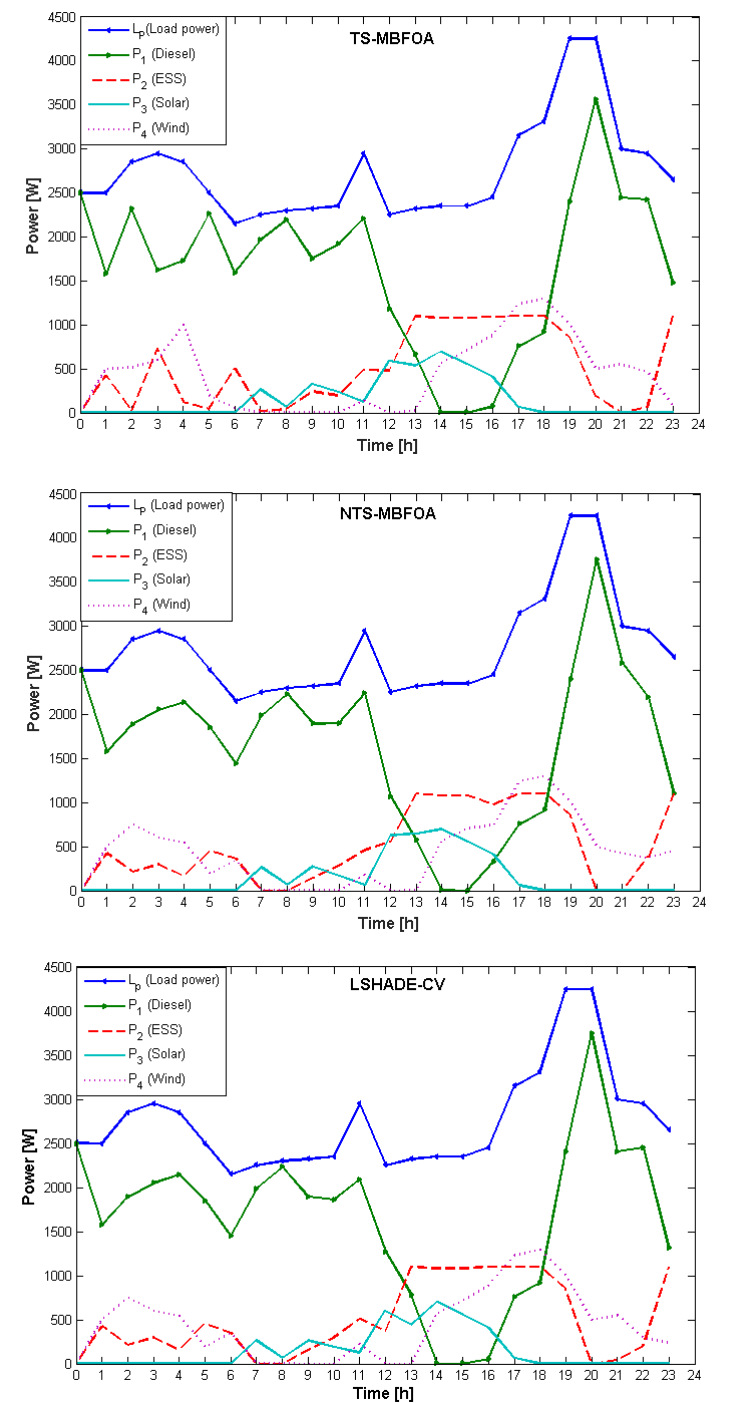
Figure 5. Visualization of the power supply during the 24 h of the day for the operation of the NIR-MG, obtained by the TS-MBFOA, NTS-MBFOA and